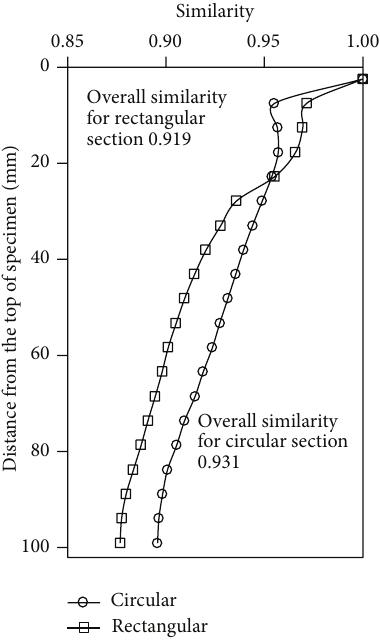
Figure 3: Similarity of stress distribution at each layer to the applied stress distribution for cylindrical and rectangular specimens.